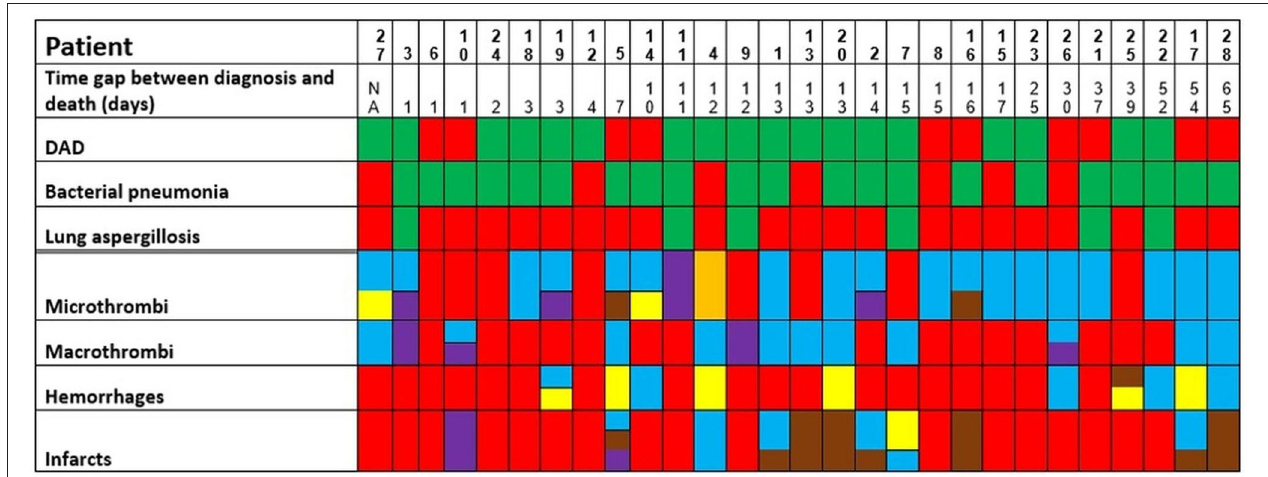
FIGURE 5 | Postmortem findings in the patients of the second wave (green: finding present, red: finding absent. Concerning micro- and macrothrombi, hemorrhages, and infarcts; the following colors to specify the anatomic localization are used: heart and/or major vessels = violet, lung = blue, brain/intracranial = yellow, liver/digestive tract = brown, kidney = orange). The patients are ordered from left to right in a crescent pattern based on the number of days between diagnosis of COVID-19 through nasopharyngeal swab and death. DAD, diffuse alveolar damage; NA, not available.